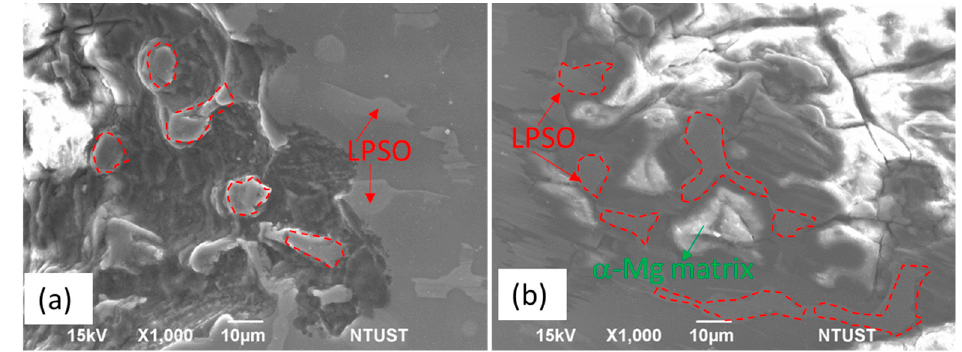
Figure 12. SEM micrograph showing surface near corrosion pits in ( a ) MgZnY-C alloy and ( b ) HA-C alloys.